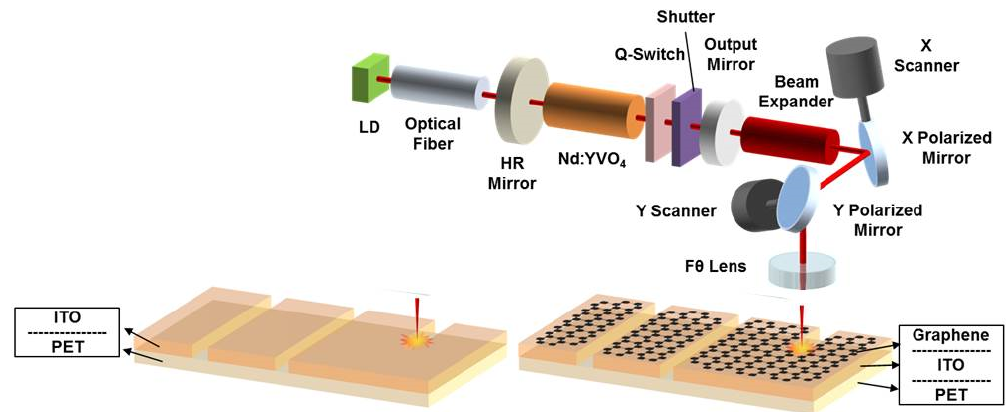
Figure 1. Schematic of the experimental setup for laser ablation of both indium tin oxide (ITO) single and graphene/ITO double layers on polyethylene terephthalate (PET) substrates.